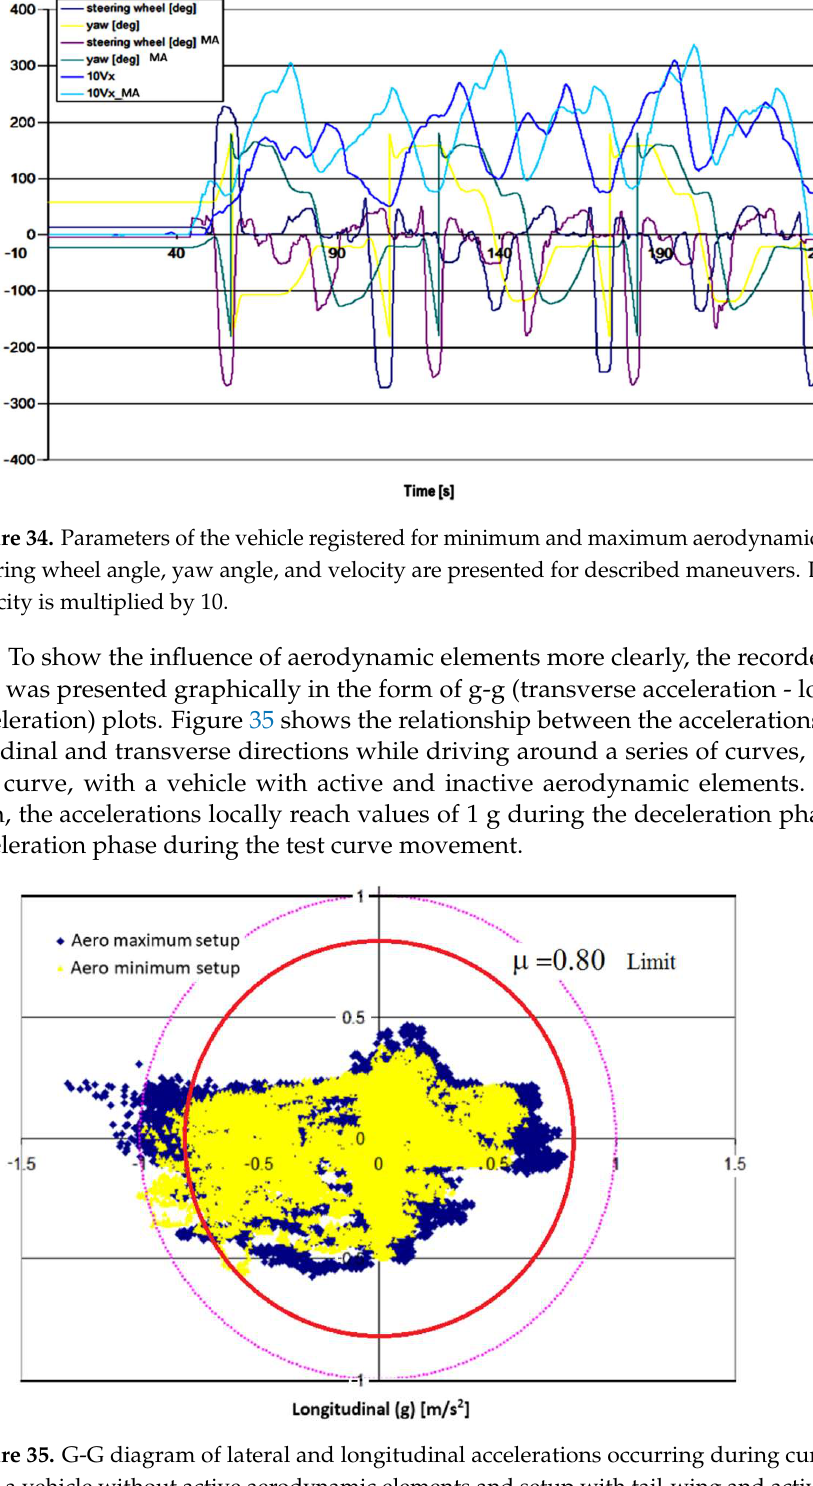
Figure 35. G-G diagram of lateral and longitudinal accelerations occurring during curved driving with a vehicle without active aerodynamic elements and setup with tail-wing and active additional aerodynamic